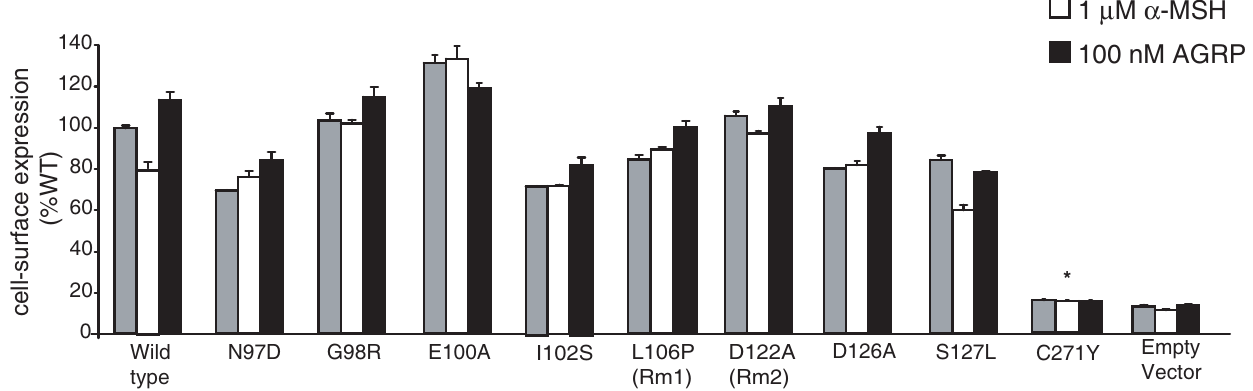
Figure 2. Cell-surface expression levels of wild-type and mutant MC4R were measured in transiently transfected HEK293 cells by ELISA. The prolactin signal sequence was added to the N-terminal domain of these receptors to ensure maximal membrane expression. MC4R mutation C271Y from TM6/EL3 significantly reduced membrane expression ( p , 0.05) and was used as a control. Empty vector (pcDNA3.1) was transfected as a negative control to detect